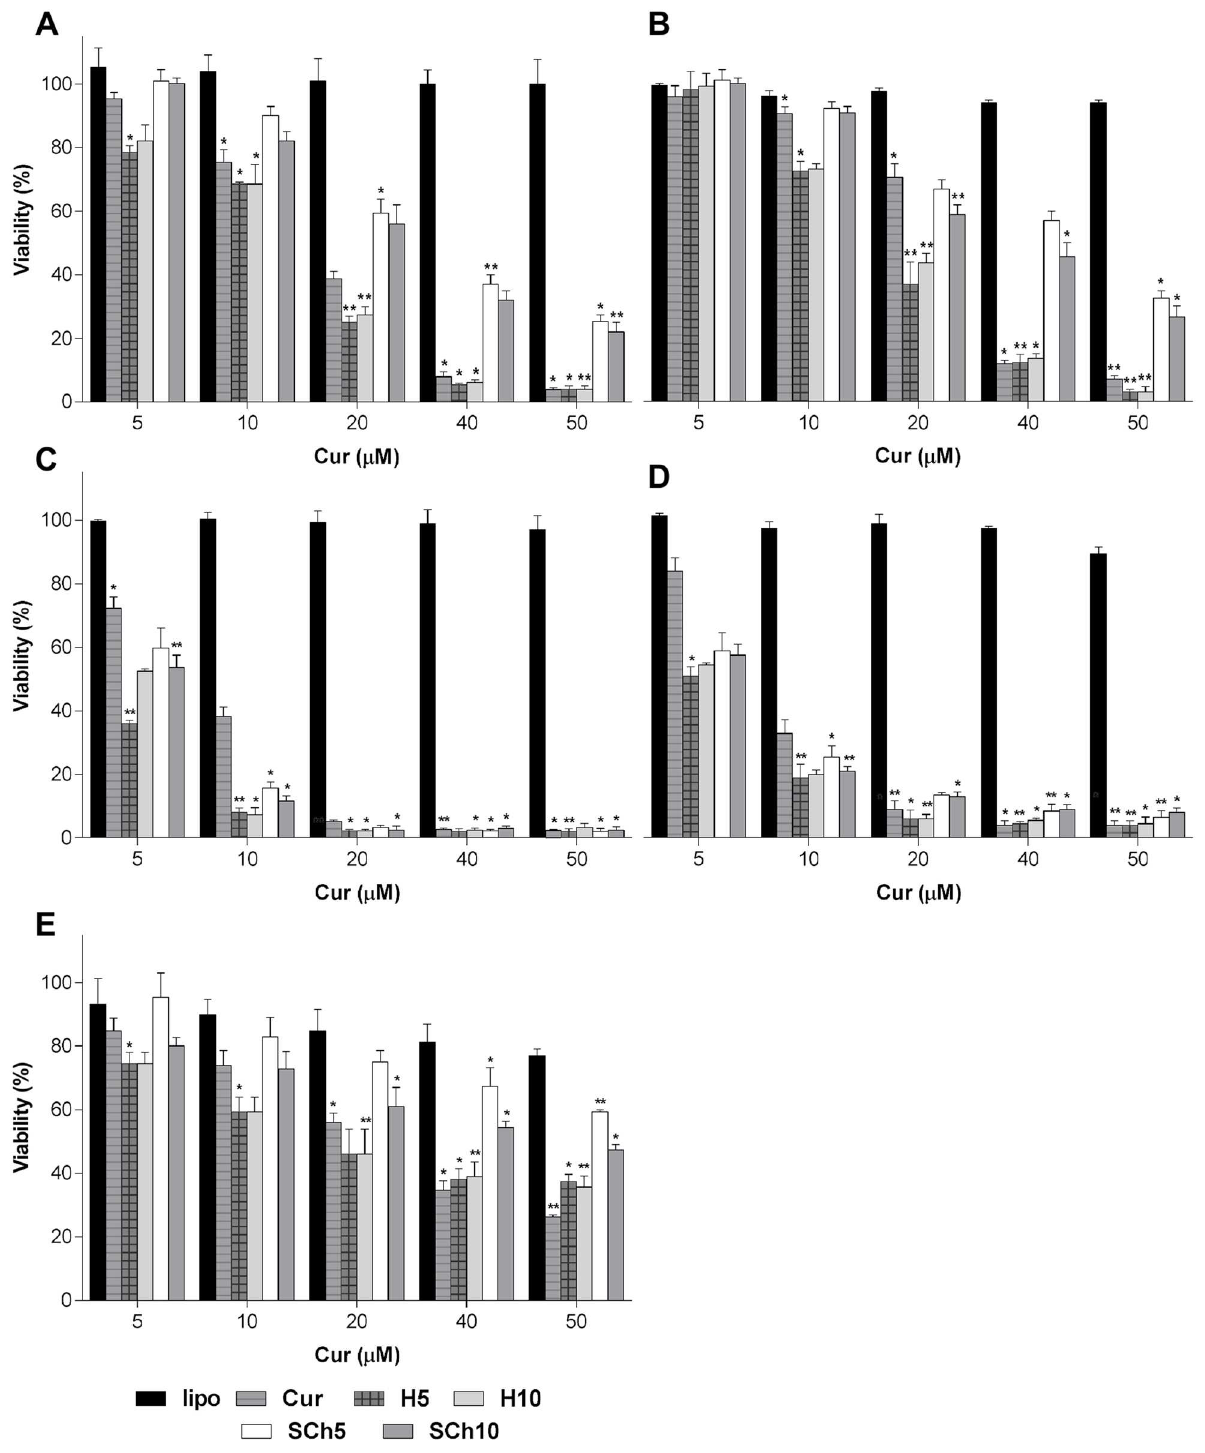
Fig 5. Cytotoxicity of free Cur, free liposomes, H5, H10, SCh5 and SCh10 formulations on AsPC-1, BxPC-3 and NDHF cells using MTT and ATP assaysfor 72 hours. (A) AsPC-1 and MTT, (B) AsPC-1 and ATP, (C) BxPC-3 and MTT, (D) BxPC-3 and ATP; and (E) NDHF and MTT. The data are shown as the mean ± SD of three independent replicates. Statistical analysisby unpairedstudent t -test: * p < 0.05; ** p < 0.001.